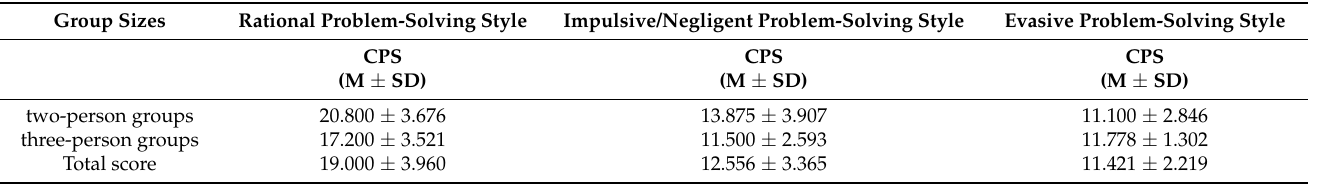
Table 3. CPS scores under different problem-solving styles and group sizes (M ± SD). Group